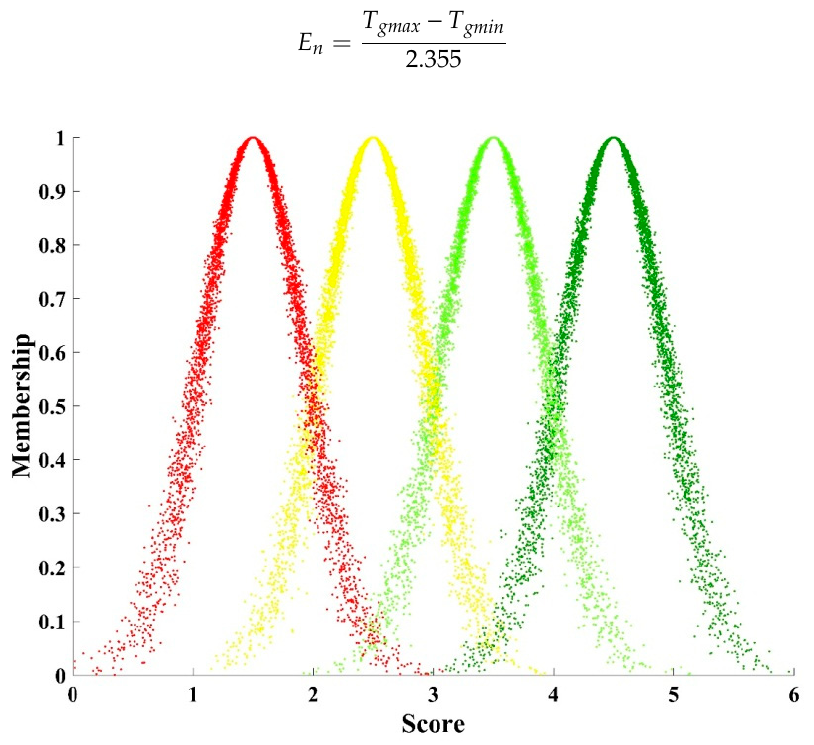
Figure 4. Modified scored standard cloud.